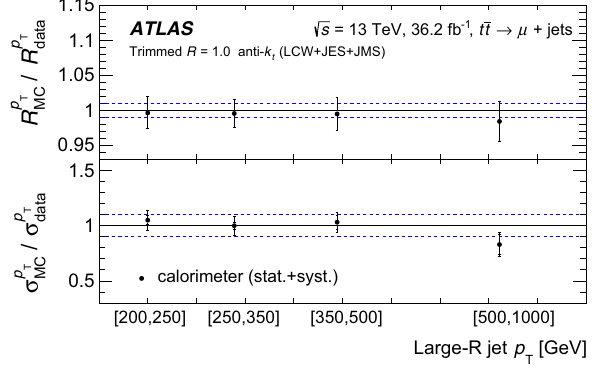
Fig. 21 Summary of the in situ measurements of the large- R jet response in t ¯ t events with a lepton+jets final state as a function of the large- R jet transverse momentum p T . The closed circles correspond to theJESandJERoftrimmedlarge- R jetsreconstructedfromcalorimeter clusters. The large- R jet p T is corrected using the simulation calibra- tion, η -intercalibration, and a combination of in situ direct balance tech- niques. The error bars represent the total uncertainty. Statistical uncer- tainties are indicated with the inner error bar (only visible on some of the points). The dashed lines, corresponding to ± 1% for the JES and ± 10% for the JER, are drawn for reference. The results in the first two p T bins (200 < p T < 250 GeV and 250 < p T < 350 GeV) correspond to a sample of high- p T W bosons, and the highest two bins correspond to high- p T top